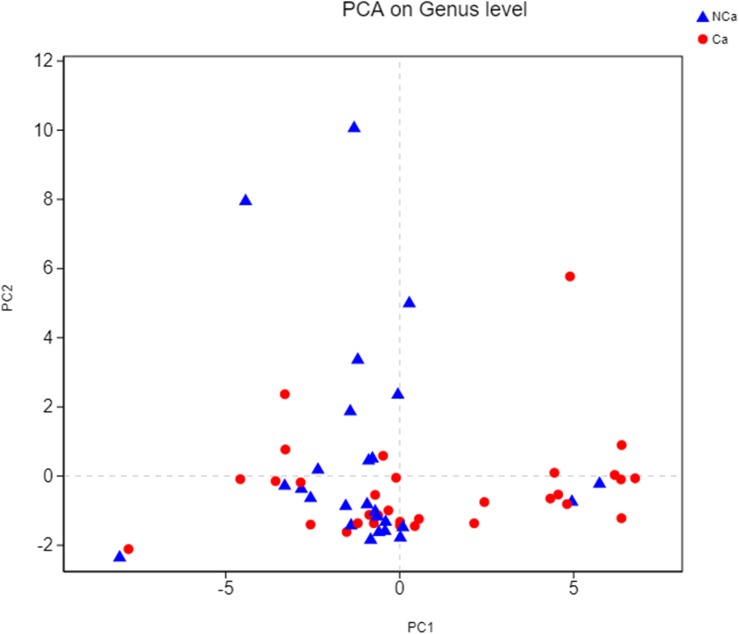
PCA on genus level.